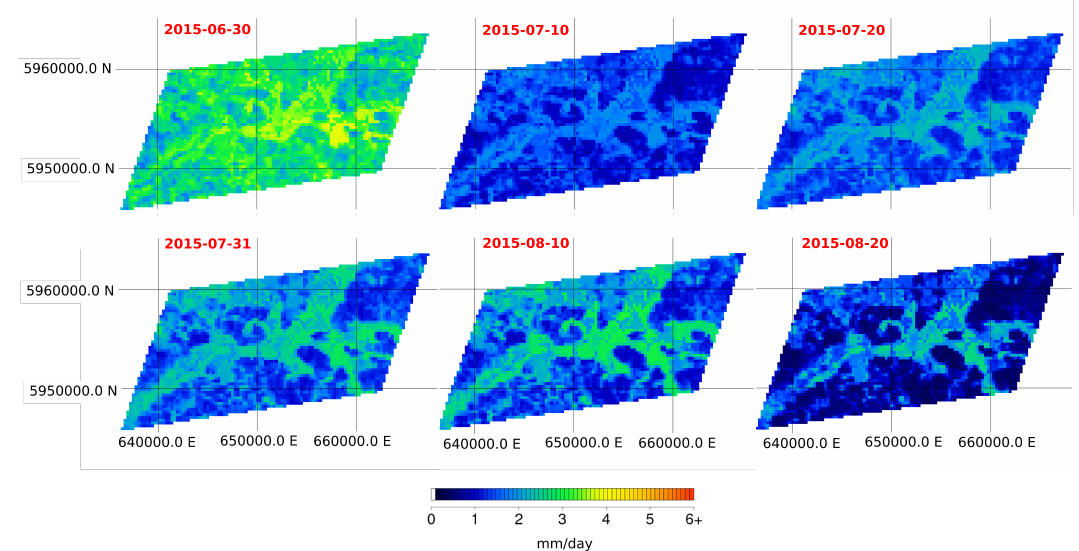
Figure 7. Daily ET in the upper Biebrza basin at a 300 m spatial resolution for different dates in